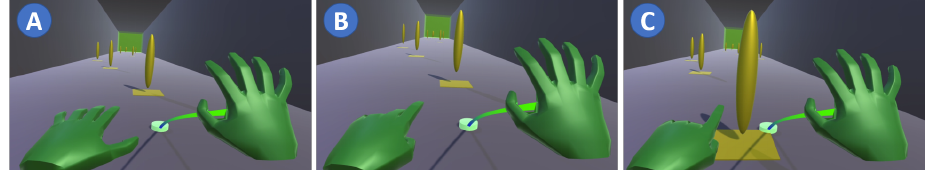
Figure 4. ( A ) Palm normal of right hand points to desired position ( B ) Left hand performs teleporta- tion gesture ( C ) User moved to position.